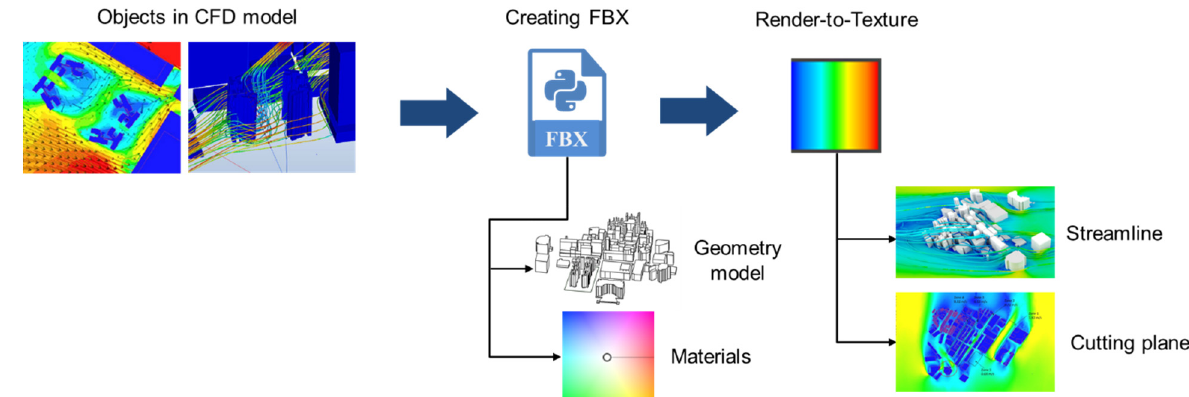
Figure 7. Render-to-texture workflow for every object in the modular buildings.